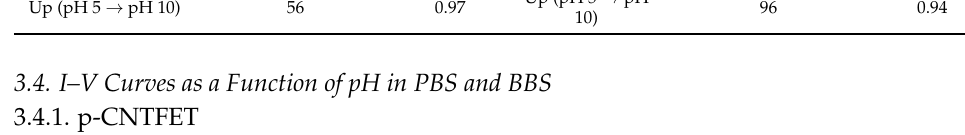
Figure 10. I–V transfer curve of ( left ) p-CNTFETs and ( right ) f-CNTFETs in PBS with respect to di ff erent pH from pH 10 to pH 4. V ds is fi xed at +0.8 V.